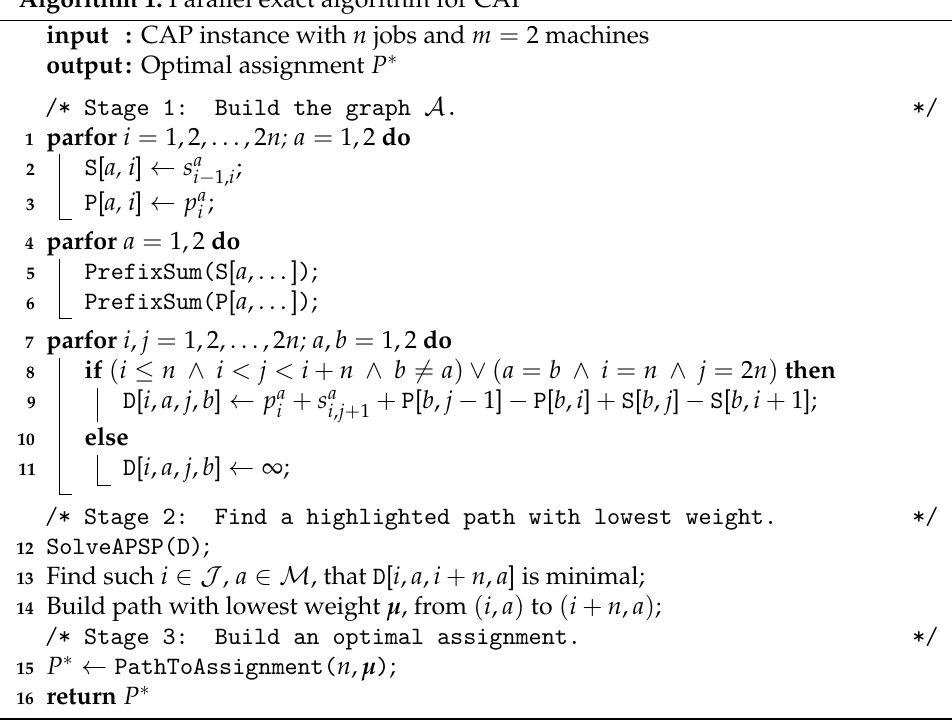
Algorithm 1: Parallel exact algorithm for